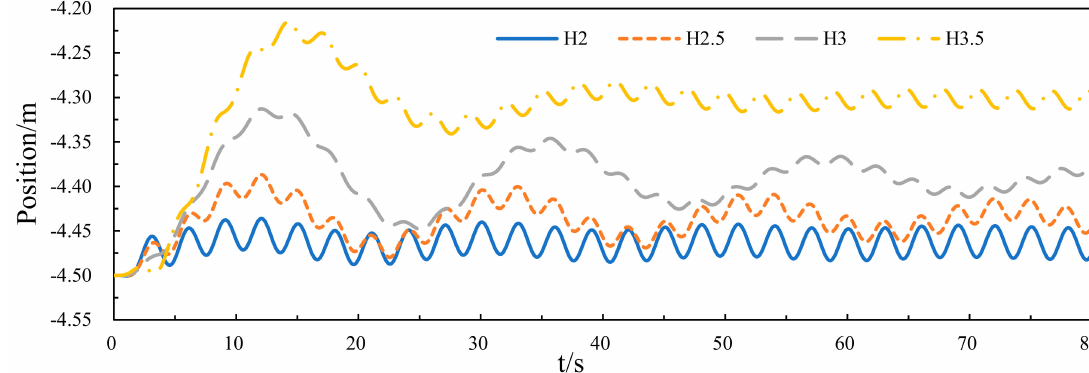
Figure 15. Oscillation curve of the central platform.